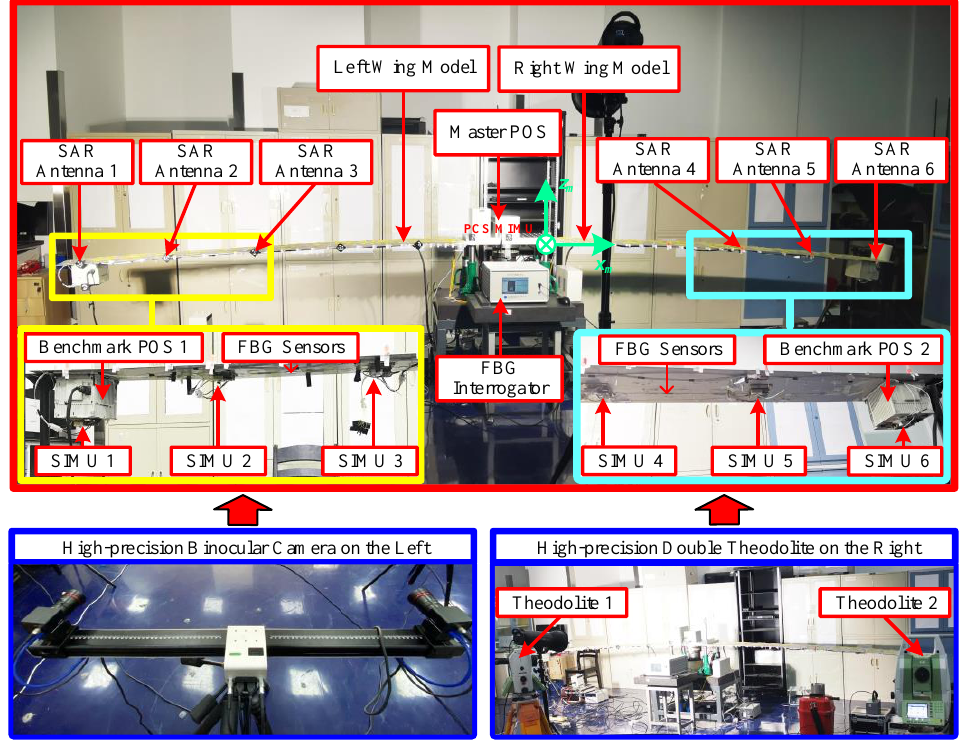
Figure 9. Experimental equipment on the ground.